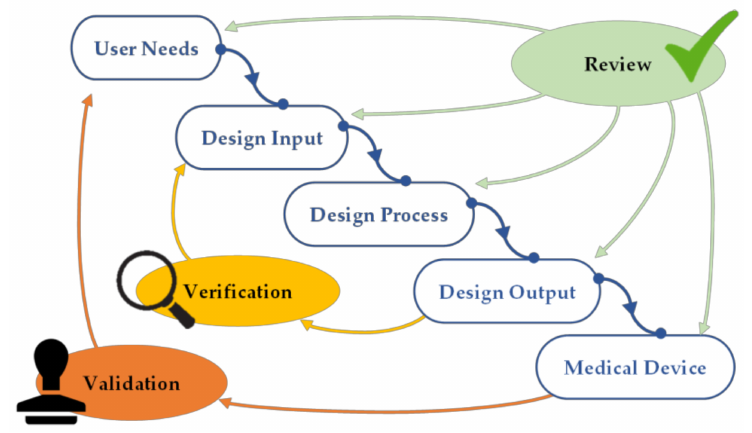
Figure 5. The traditional linear waterfall approach for the design and development process.